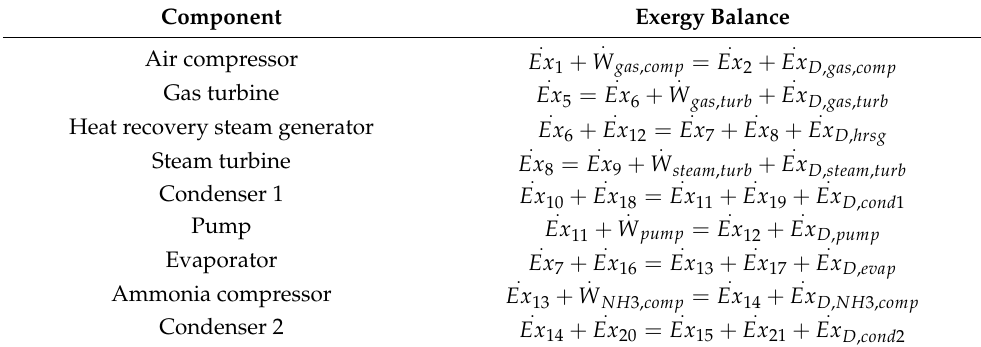
Table 1. Exergy relations for the exergy analysis of the system’s components.